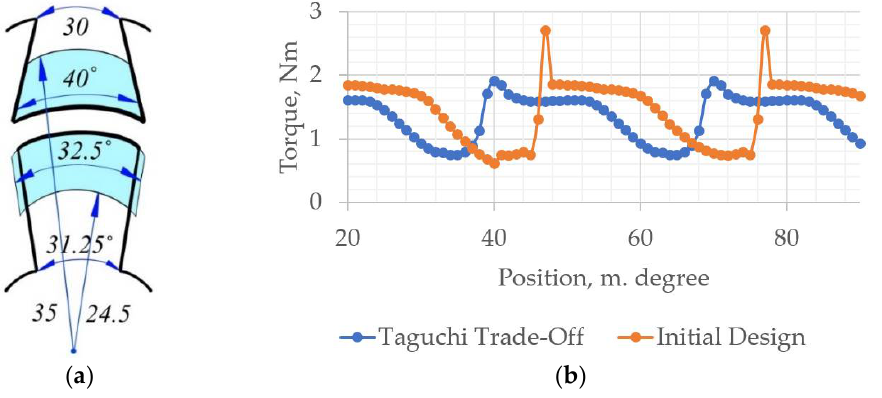
Figure 19. ( a ) Topology optimization design domain; ( b ) Torque comparison of initial and trade- off designs.